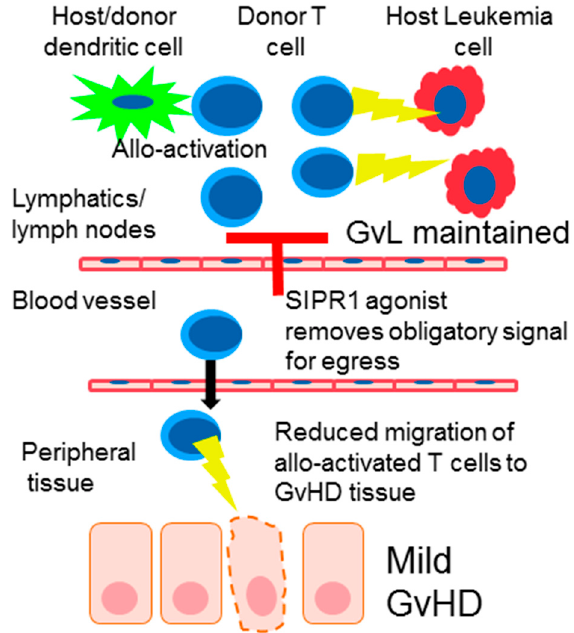
Figure 2. Pharmacological inhibition of S1PR signaling (denoted by red T shape) removes the obligatory signal required by activated donor T cells to egress from the lymph node. Consequently, less donor allo-activated T cells migrate to peripheral tissue resulting in reduced GvHD. However, the GvH reaction is maintained in the lymphatic system and directed towards leukemia cells resulting in effective GvL.